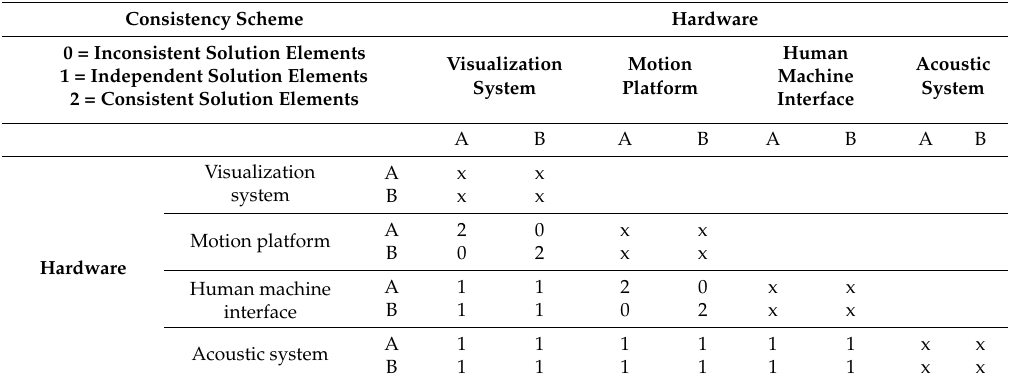
Table 5. Consistency matrix of driving simulator solution elements (excerpt)